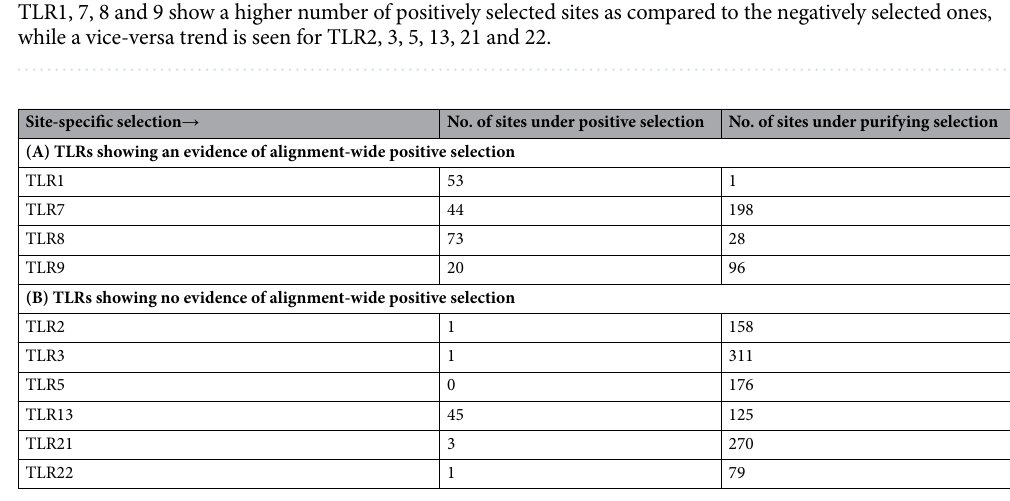
Table 1. The TLRs in the study have been divided into two parts—(A) and (B) in the table, based on the results of alignment-wide selection analysis via PARRIS. The site-based selection methods (SLAC, FUBAR, MEME) have been used to deduce the sites under positive and purifying selection for each of the TLRs. To maintain the stringency of parameters, the sites in the table have been deduced only if they were detected via two or more analysis